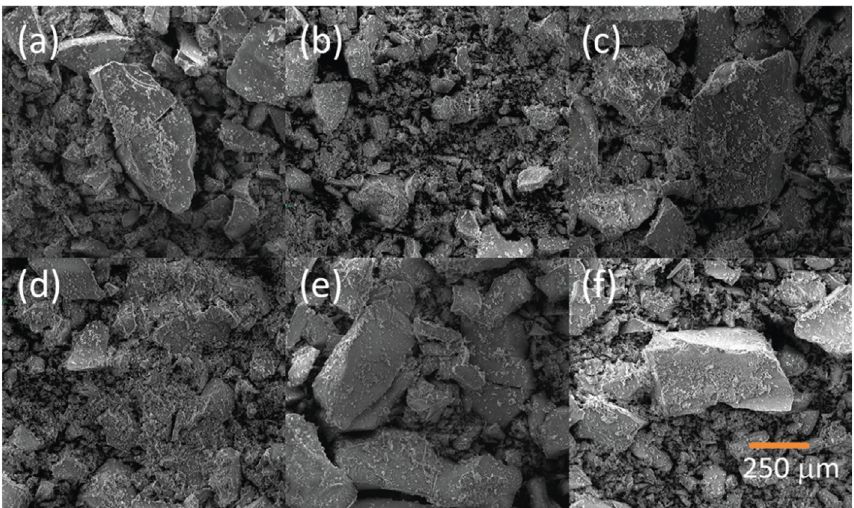
Figure 3: SEM images of opal samples: (a) Ds-1, (b) Ds-2, (c) Ds-3, (d) Ds-4, (e) Ds-5, and (f)